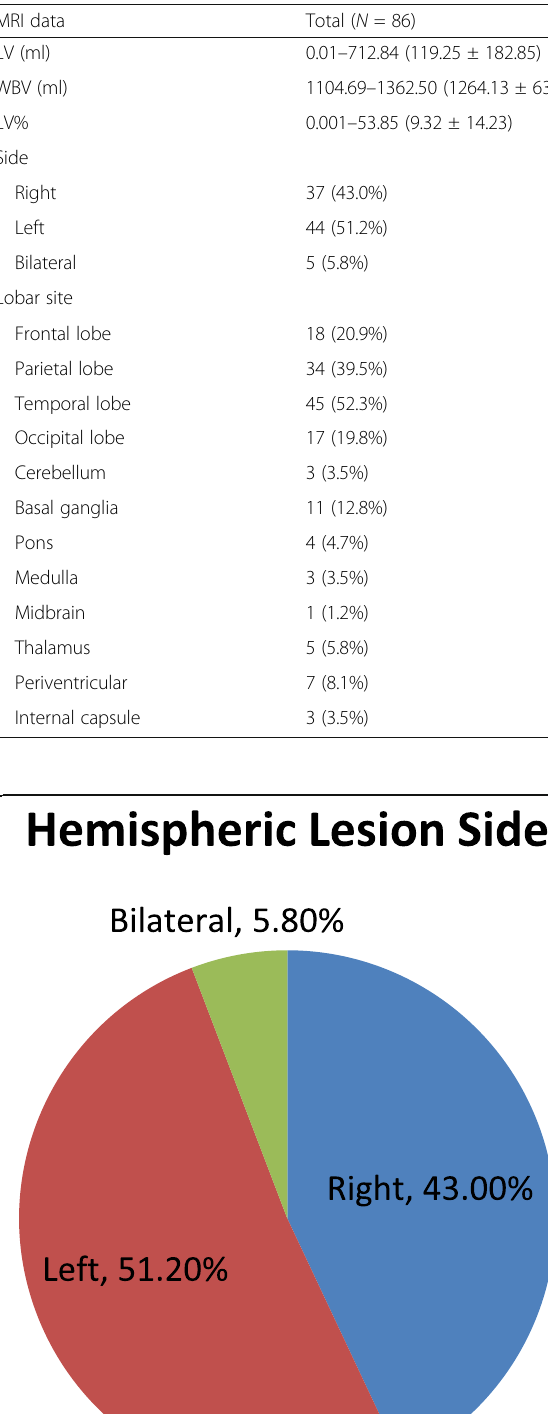
Table 4 SPD-CAT total and content units scores among study group